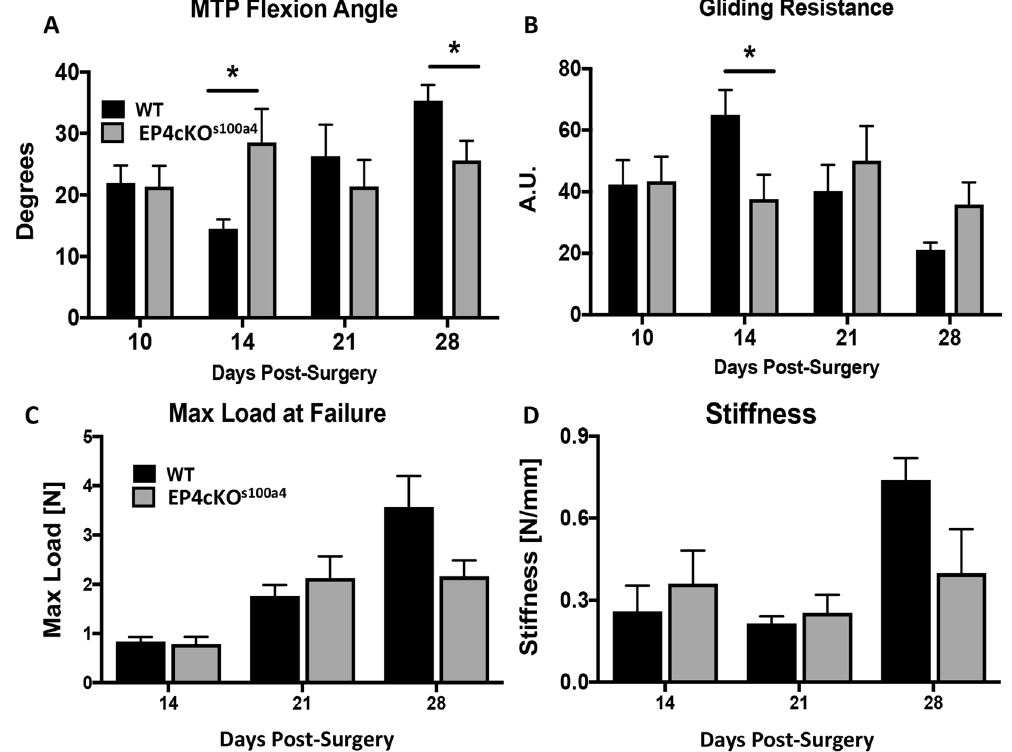
Figure 4. EP4cKO S100a4 significantly improves early gliding function without compromising mechanical properties during flexor tendon healing. ( A ) MTP Flexion Angle, and ( B ) Gliding Resistance were measured in WT and EP4cKO S100a4 flexor tendons between 10–28 days post-surgery. ( C ) Max load at failure, and ( D ) Stiffness were assessed between 14–28 days post-surgery. For tensile testing, all repaired tendons failed at the suture site. ( * ) Indicates p < 0.05 between WT and EPcKO S100a4 at the same